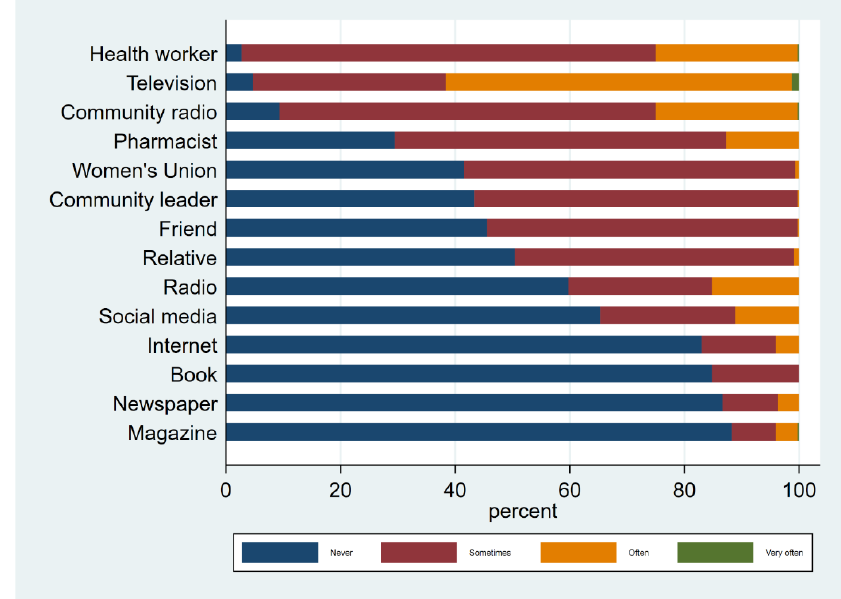
Figure 3. Frequency of access to health information sources.